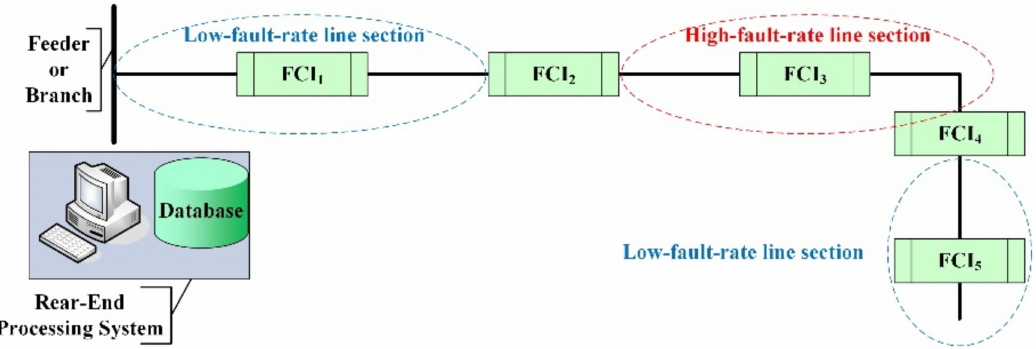
Figure 7. Different fault rates in feeder or branch